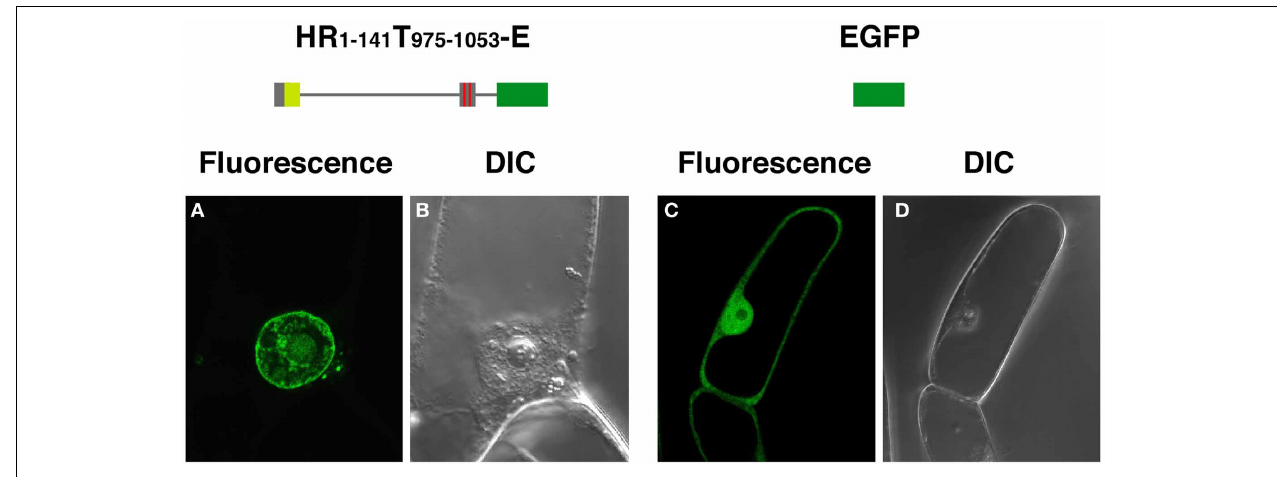
FIGURE 3 | HR 1 − 141 T 908 − 1053 -E expressed in BY-2 cells localizes to the nuclear periphery. BY-2 cells were transformed by an Agrobacterium -mediated transformation method, using a binary vector (B) and (D) show corresponding DIC images.